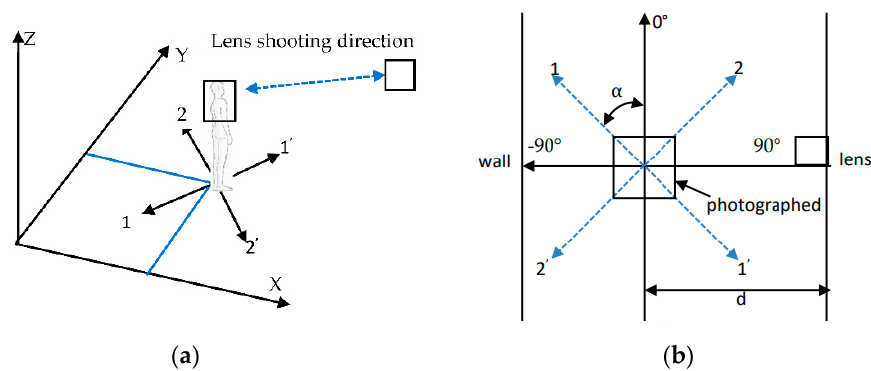
Figure 3. Static human ear fixed-point shooting; ( a ) 3D schematic diagram; ( b ) plane schematic diagram. In the process of rotating clockwise from the direction of position 2’ ( − 135 ◦ ) to the direction of position 1’ (135 ◦ ), we collected images from seven angles: the back left ear ( − 135 ◦ , − 150 ◦ , − 165 ◦ ), right left ear (180 ◦ ) and the front left ear (165 ◦ , 150 ◦ , 135 ◦ ). We took